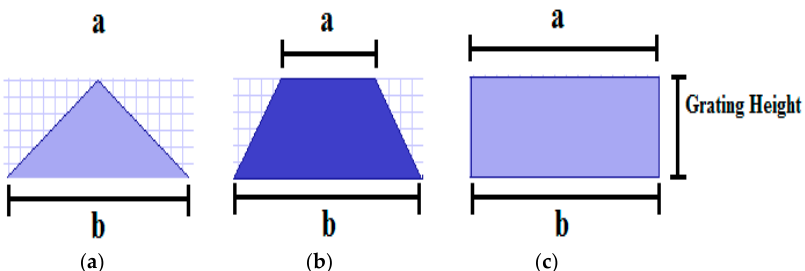
Figure 4. Geometric shape design of nano ‐ grating structures those are used in the simulations. ( a ) triangular ‐ shaped SWG; ( b ) trapezoidal ‐ shaped SWG; and ( c ) rectangular ‐ shaped SWG.